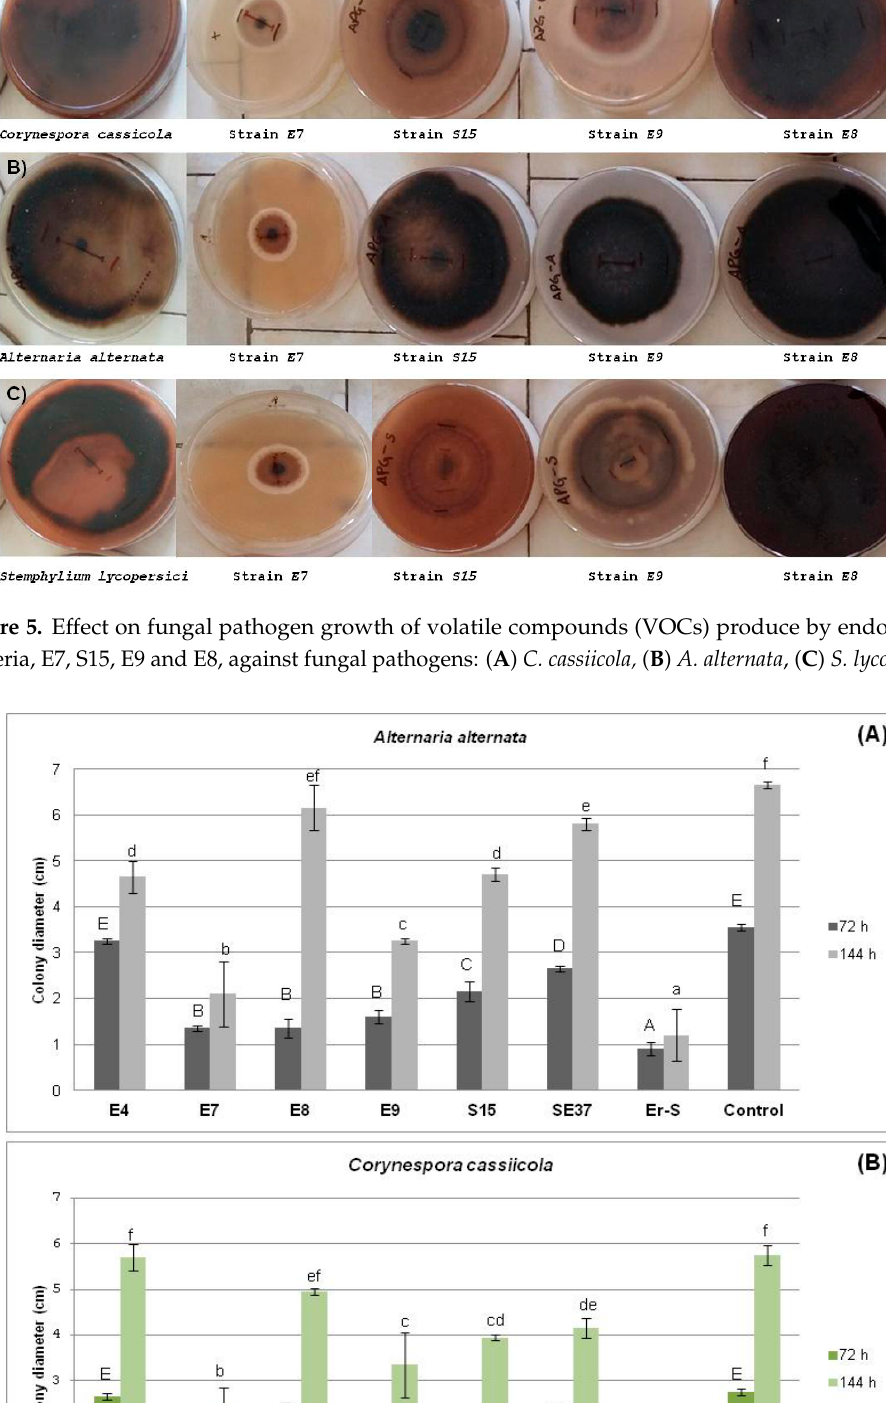
Figure 6. Antifungal activities of volatiles from endophytic bacteria (E4, E7, E8, E9, S15, SE37 and Er-S as control) against fungal pathogens: ( A ) A. alternata , ( B ) C. cassiicola and ( C ) S. lycopersici. Values are means of three independent biological replicates and error bars represent the standard deviation, letters in common on the bars are not significantly different according to the Tukey test at p ≤ 0.05. 3.3. Plant Growth Promotion Assays In order to determine whether endophytes of tomato seeds and seedlings have the potential to promote plant growth, the 21 taxonomically identified isolates were evaluated for their capacity to promote the growth of tomato plants in axenically-grown tomato plants. They were compared with the growth of un-inoculated controls and plants inoculated with P. fluorescens . Seedling length and